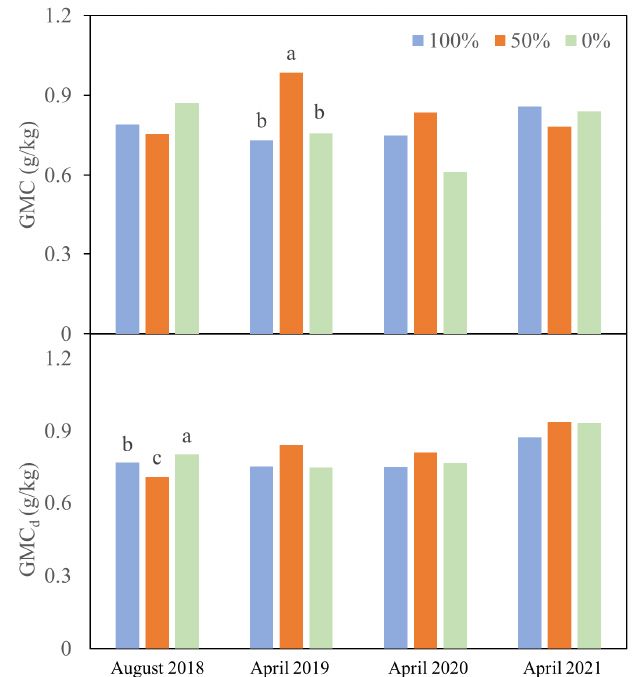
Figure 8. 𝐺𝑀𝐶 and 𝐺𝑀𝐶 (cid:3031) values under di ff erent residue removal rates. Di ff erent lowercase le tt ers Figure 8. GMC and GMC d values under different residue removal rates. Different lowercase letters above the bars indicate signi fi cant di ff erences among treatments ( 𝑝 < 0.05 ). above the bars indicate significant differences among treatments ( p <